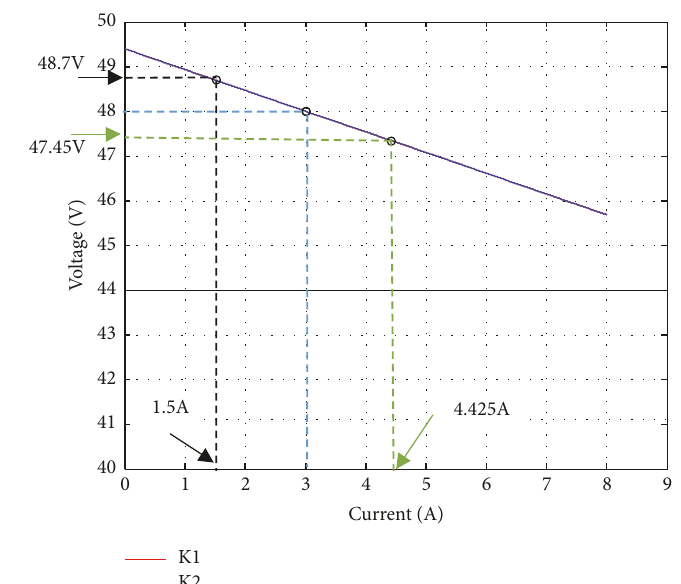
Figure 12: Zero mismatch in load regulation characteristic of the droop method for the two